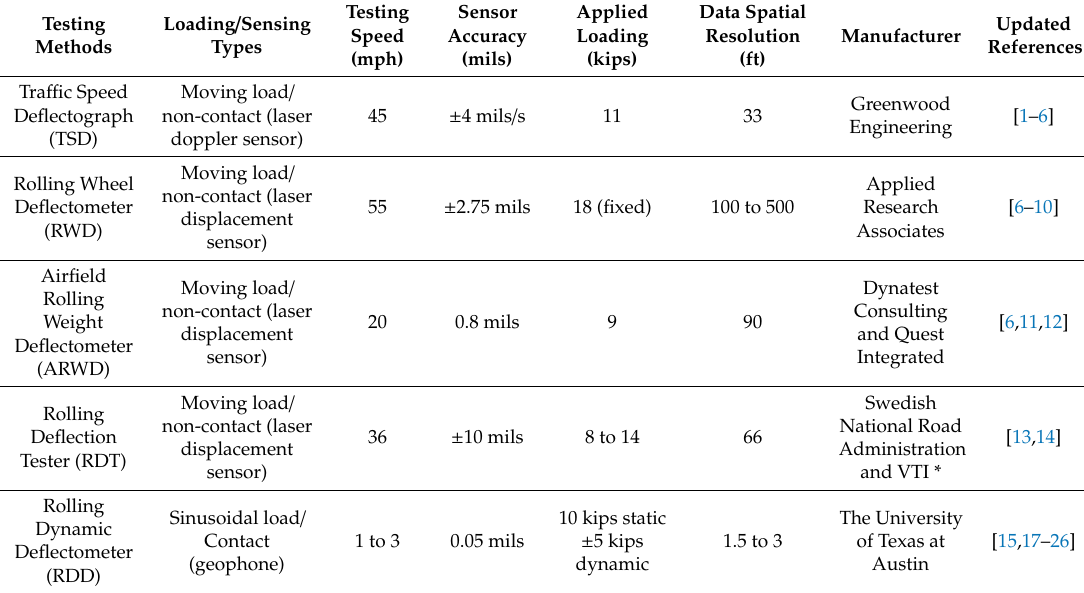
Table 1. Testing devices for continuous pavement deflection